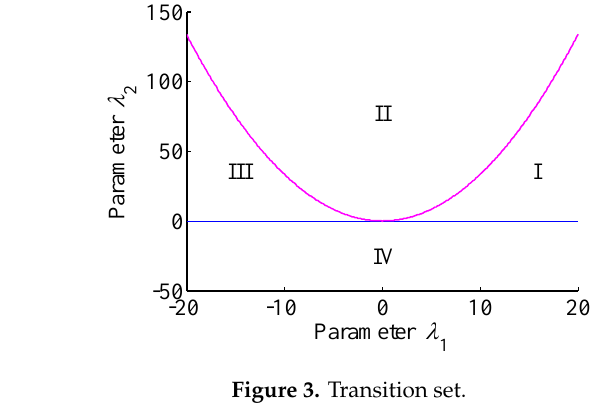
Figure 3. Transition set .